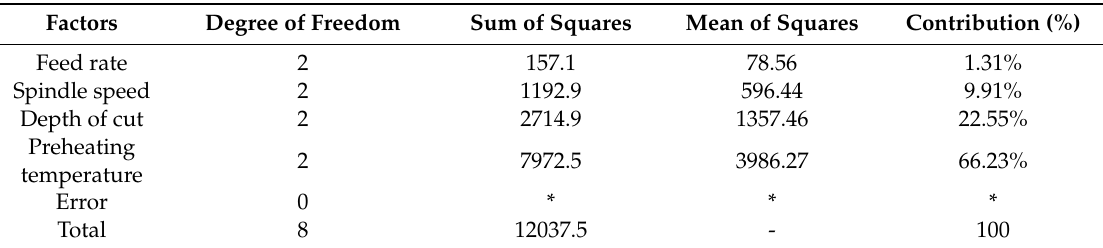
Table 9. The analysis results of variance for cutting force.